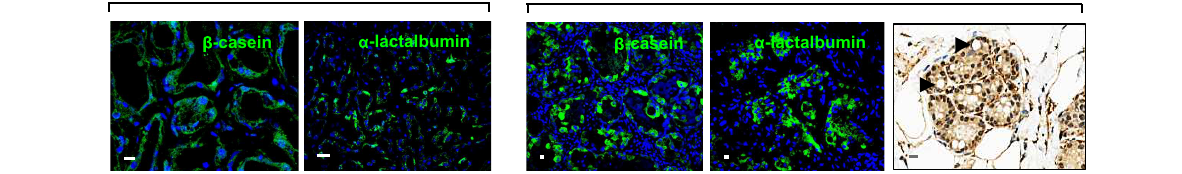
FIGURE 1 | Expression of OCT4 in the normal resting and lactating breast, and in breast tumors with lactating features or associated with pregnancy and lactation. (A) IHC and IF staining of OCT4. Scale bars: 50 µ m (IHC) and 20 µ m (IF). Minimal and mostly cytoplasmic expression was seen in the normal resting breast. During normal lactation, OCT4 was upregulated and expressed in both the nucleus and cytoplasm, with varying expression and subcellular localization between different tissues, and